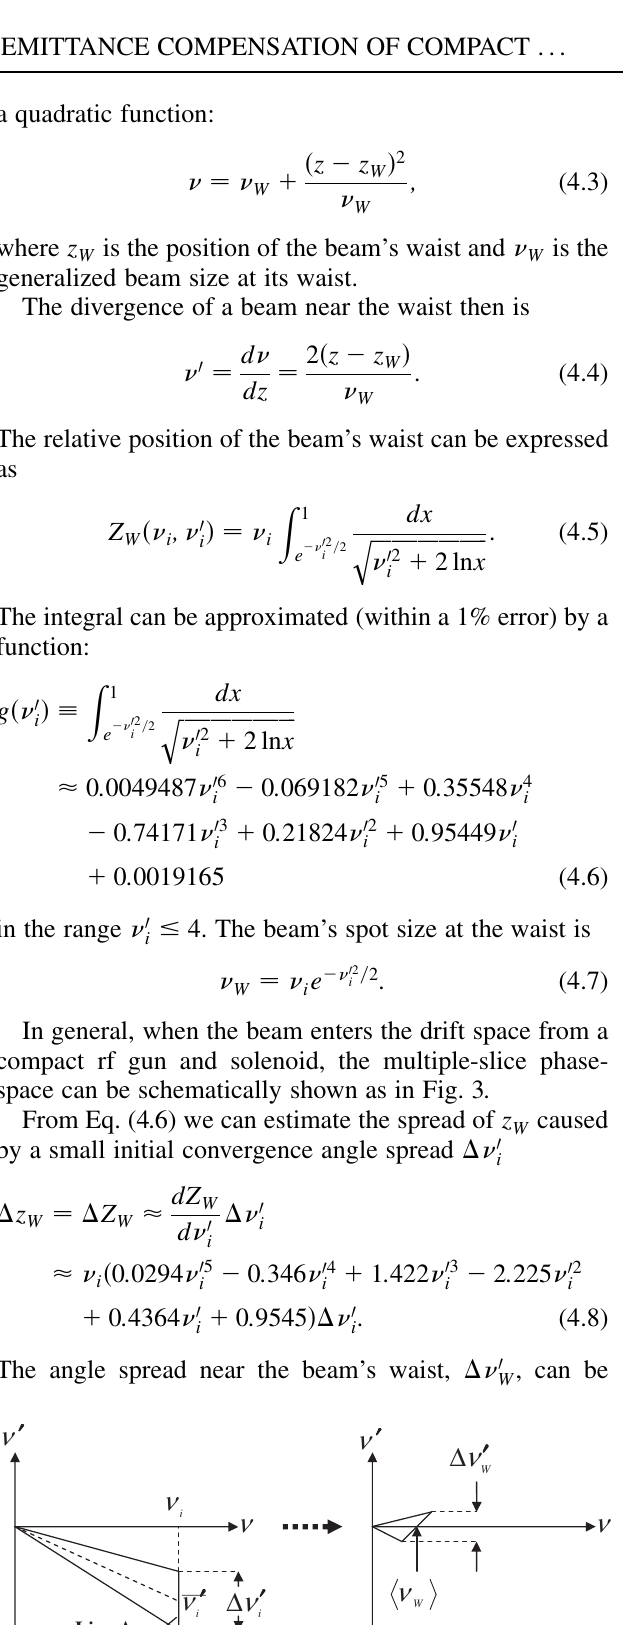
FIG. 4. The relative emittance at the beam’s waist ( " as a function of the initial convergence angle. Because of the approximation of the spread of the waist’s position in Eq. (4.8), the emittance becomes zero near j (cid:6) 0 would not be the case, but the minimum would be in the same